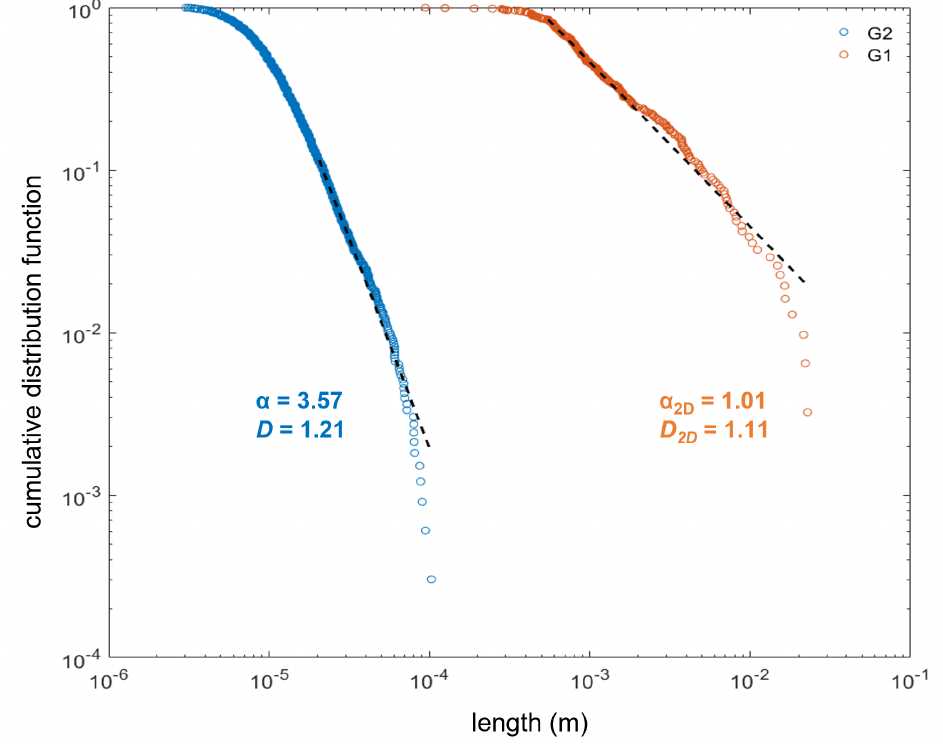
Figure 8. Fracture length distribution for rock shale samples G1 and